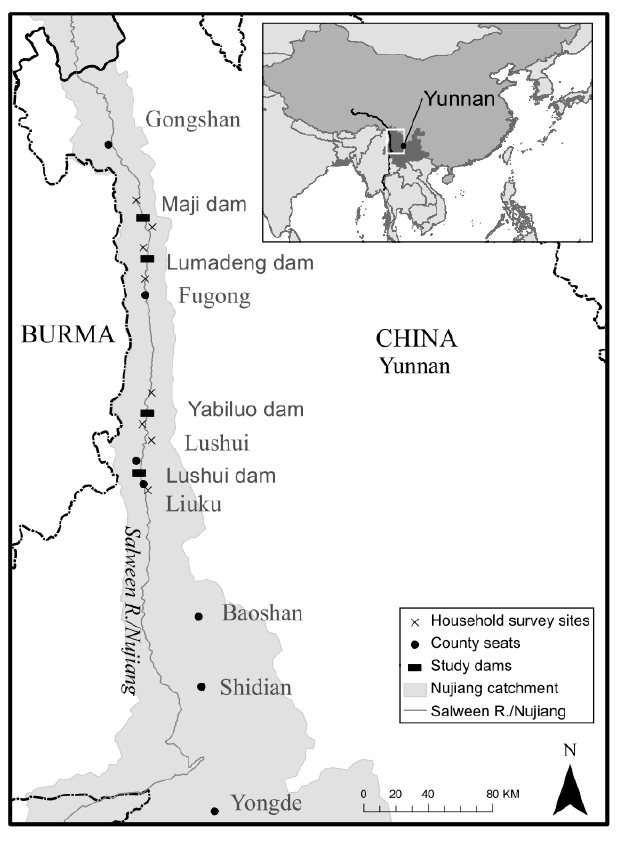
Fig. 1. Map of the study site, indicating the location of the four proposed